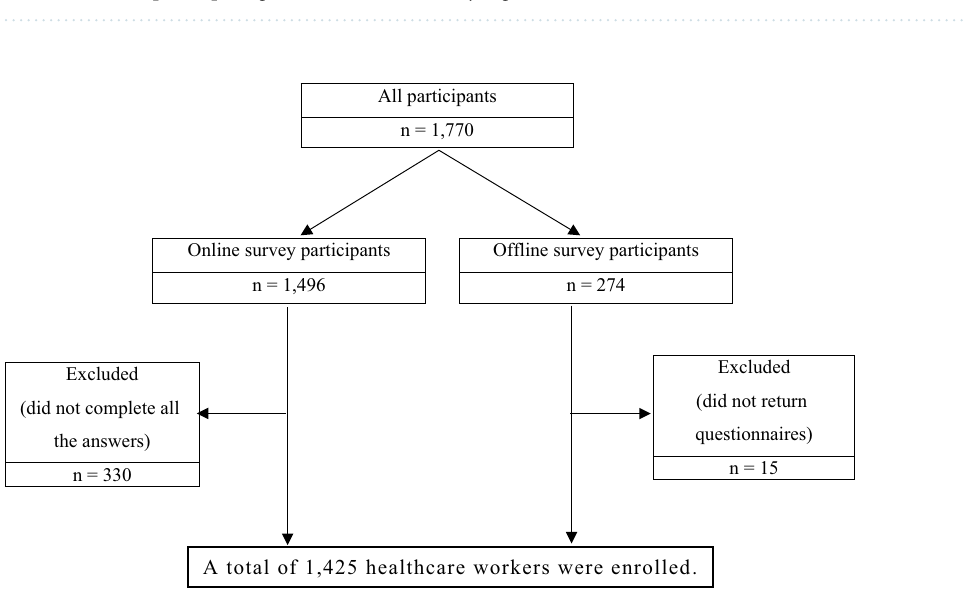
Table 1. List of participating medical institutions by region.